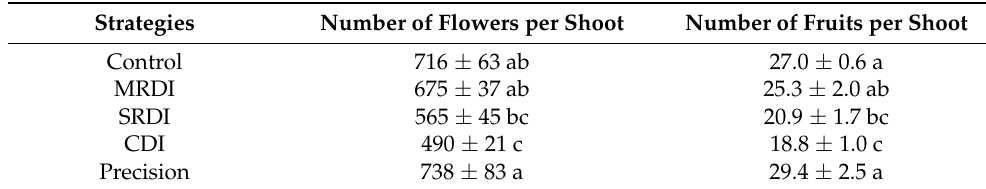
Table 6. Average of the number of flowers and fruits per shoot, and fruit setting rate at the end of the experiment. (MRDI: moderate regulated deficit irrigation; SRDI: severe regulated deficit irrigation; CDI: continuous deficit irrigation). Different letters showed significant differences ( p ≤ 0.05) among treatments according to Duncan’s test.